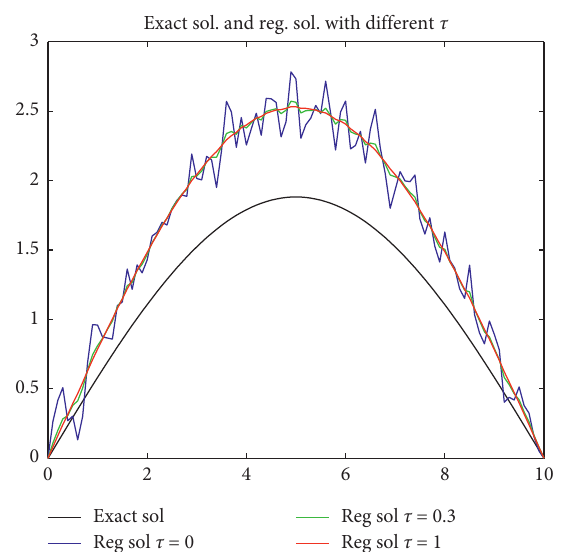
Figure 8: The exact solution (black) and the regularized solution with ε � 10 − 3 and c � 0 (blue), c � 0 . 3 (green), and c � 1 (red).